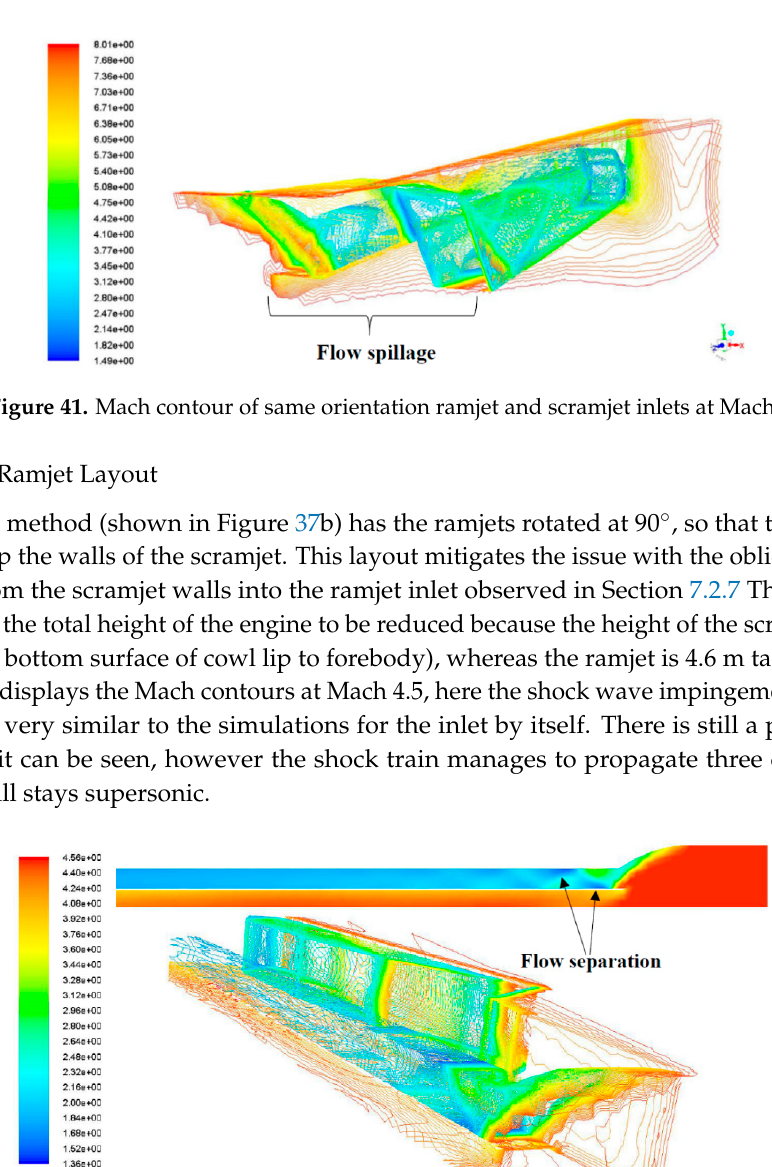
Figure 42. Mach contour of the rotated ramjet inlets at Mach 4.5.